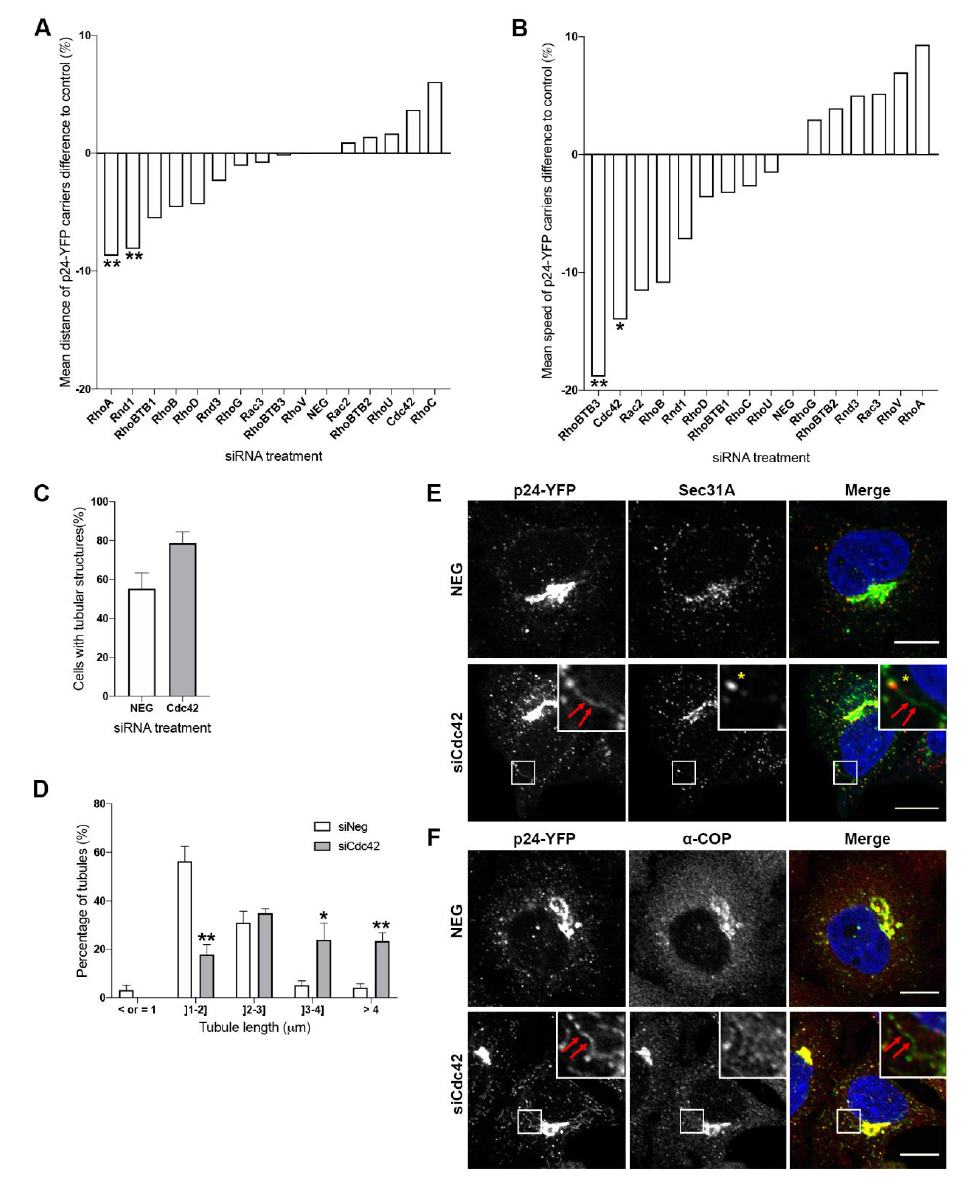
Figure 2. RhoBTB3 and Cdc42 depletion affects the transport of p24-YFP carriers. ( A ) Graph showing the difference in mean distance travelled by p24-YFP carriers in cells depleted of Rho GTPase proteins, as a % of the distances travelled in control cells (NEG siRNA-treated cells). ( B ) Graph showing the difference in mean speed of p24-YFP carriers in cells depleted of Rho GTPase proteins, as a % of the speed travelled in control cells (NEG siRNA-treated cells). ** p < 0.01 and * p < 0.05 compared with NEG control cells. n = 3 independent experiments with at least 17 cells analysed per treatment. ( C ) Graph showing the percentage of cells containing tubular carriers in control and Cdc42-depleted cells. n = 3 independent experiments, with at least 28 cells analysed in total. ( D ) Graph showing the percentage of tubular carriers of indicated sizes in NEG siRNA-treated cells (white bars) and Cdc42-depleted cells (grey bars). ** p < 0.01 compared with NEG control cells. n = 3 independent experiments with at least 64 cells analysed in total. ( E ) HeLa cells stably expressing p24-YFP and treated with either NEG siRNAs or siRNAs targeting Cdc42 were stained with antibodies against Sec31A. Red arrows indicate a tubular carrier extending from an endoplasmic reticulum (ER) exit site (ERES) marked by anti-Sec31A (yellow asterisk). ( F ) Cells stably expressing p24-YFP and treated with either NEG siRNAs or siRNAs targeting Cdc42 were stained with antibodies against α -COP. Red arrows indicate a tubular carrier that is devoid of the COPI coat. Bars represent 10 µ